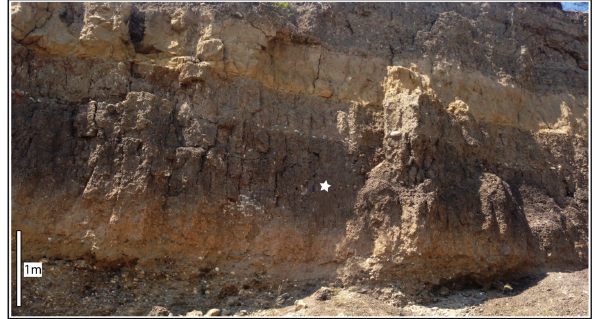
Figure 5. Modern Holocene deposits from where pedogenic carbonates were collected and analyzed to achieve the modern isotopic fingerprint of meteoric water and soil-respired CO 2 in the Bagua Basin. White star shows where the pedogenic carbonates were sampled.